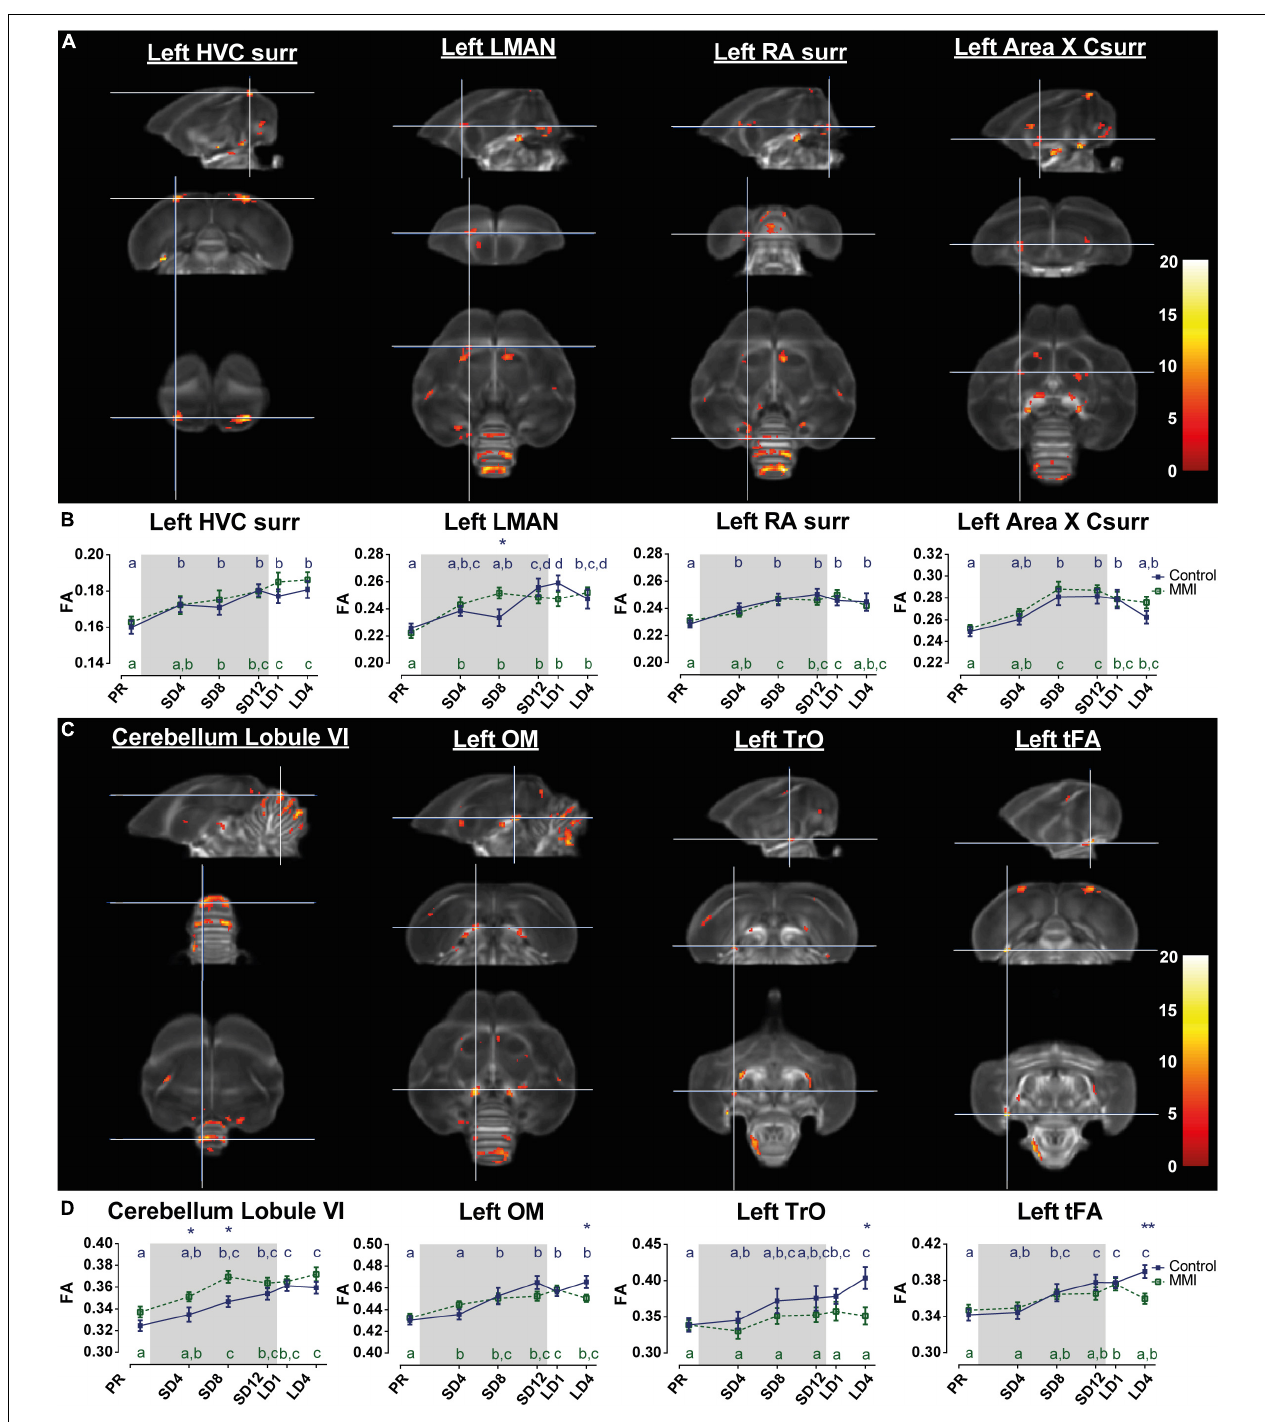
FIGURE 5 | Voxel-based flexible factorial analysis revealed time effect in the song control system (A) , cerebellum and several white matter tracts (C) . The longitudinal changes over time of the extracted diffusion parameter fractional anisotropy (FA) of each ROI-based cluster is displayed below (B,D) . The statistical maps were assessed at p uncorr < 0.001 and k E ≥ 20 voxels with a small volume correction including regions of the song control system, white matter structures and the cerebellum. Significant voxels are color coded according to their F–values displayed on the scale on the right. The gray area indicates the photosensitive period of short days (8L:16D). Post-hoc statistical testing with Tukey’s HSD multiple comparison ( p < 0.05) correction revealed significant differences between different time points, visualized by different letters. If two time points share the same letter, the DTI values are not significantly different from each other. Significant group differences at specific time points are indicated by *(p < 0.05) or ** (p < 0.01). Error bars shown are the standard error of the mean. Csurr, caudal surroundings; surr, surroundings.